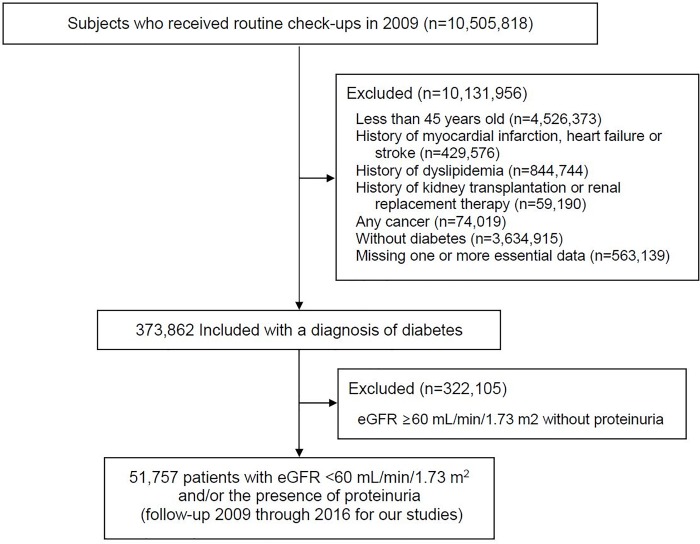
Flow chart of a cohort of 51,757 patients in the final analyses.eGFR, estimated glomerular filtration rate.